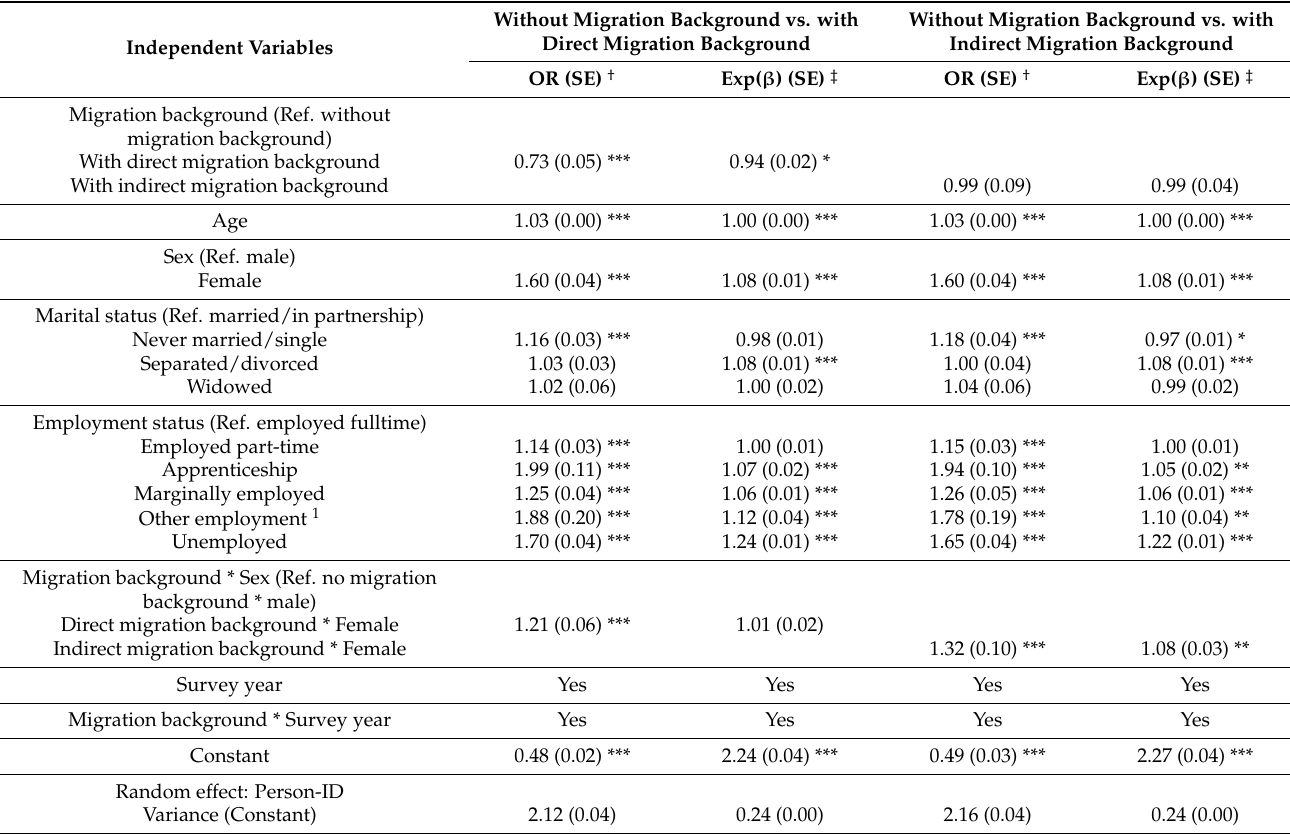
Table 2. Multilevel mixed-effects logistic regressions of doctoral visits within three months (yes/no) and zero-truncated multilevel mixed-effects generalized linear models of number of doctoral visits within three months for persons without and with direct or indirect migration background (years 2013 to 2019, n = 43,921; 179,357 observations). Without Migration Background vs. with Without Migration Background vs. with Direct Migration Background Indirect Migration Background Independent Variables